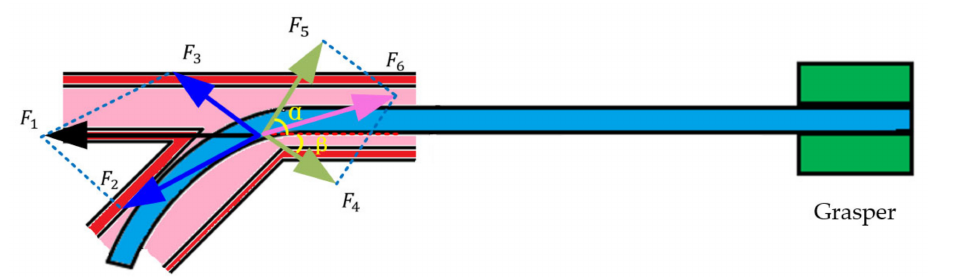
Figure 4. The force analysis of the catheter. α and β are angular dimensions, which have been marked in yellow and bold in the figure.